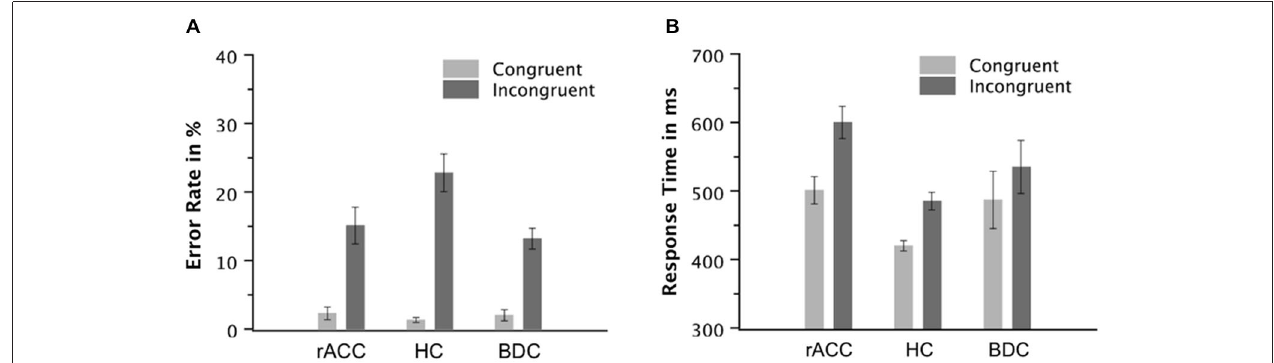
Group), in healthy controls (HC Group), and in patients with brain lesions outside the frontal lobes (BDC Group). ms, milliseconds; Error bars represent standard errors of the